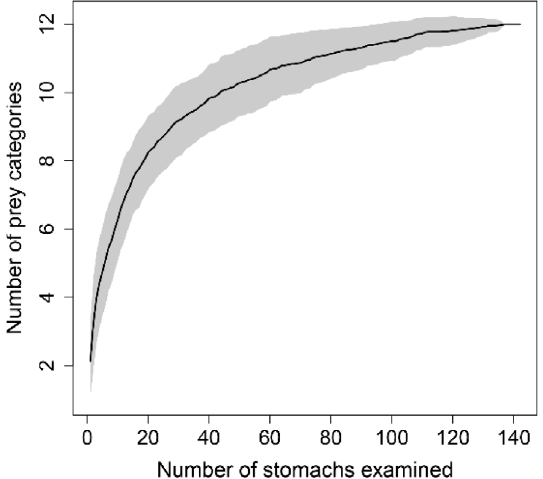
Fig. 3. Cumulative number of prey categories (solid line) and associ- ated 95% confidence intervals from standard deviation (shaded area) for all sampled